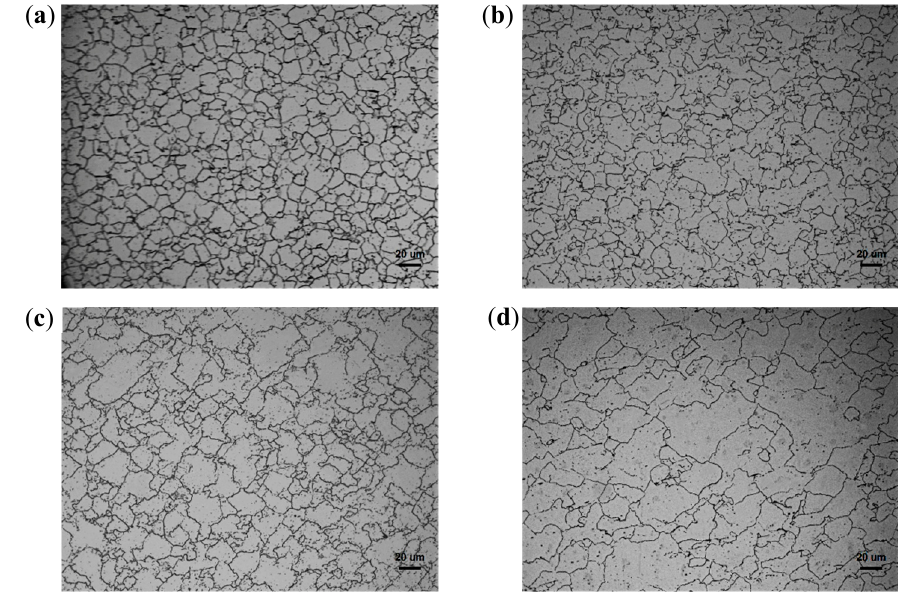
Figure 9. The weld zone (WZ) microstructure of specimens ( a ) No.1, ( b ) No.2, ( c ) No.3, and ( d ) No.4.